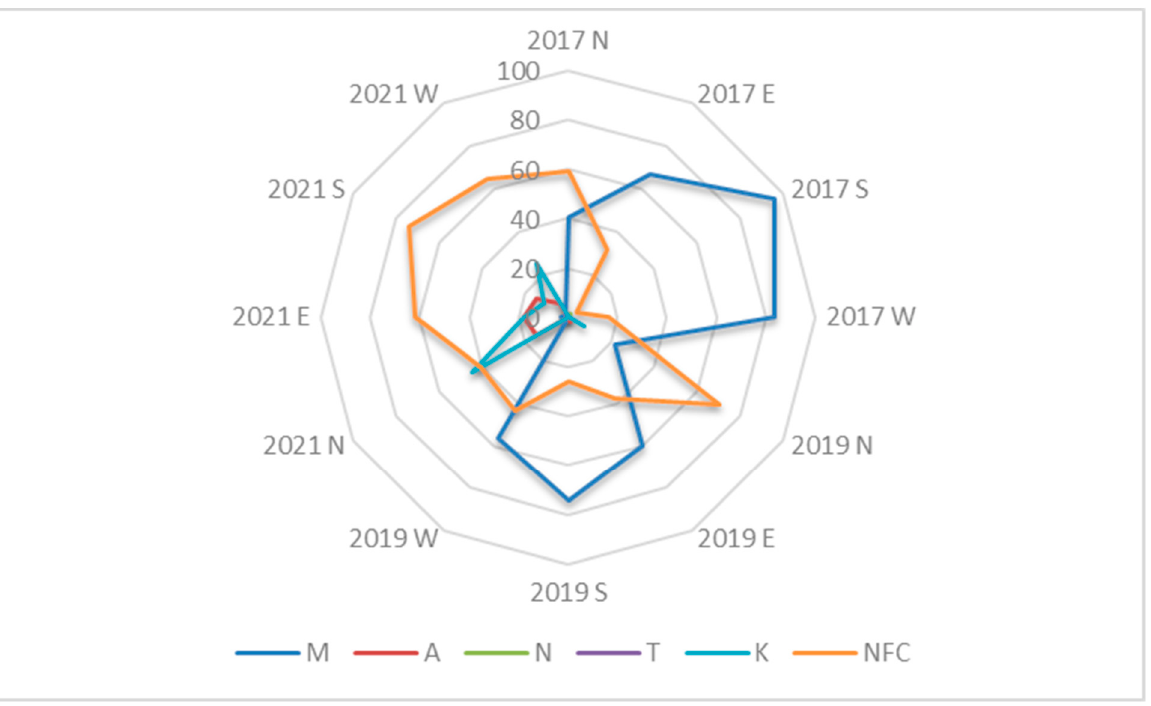
Figure 1. Dynamics of plant vegetation classes in the segments of the vertical green columns in rela-